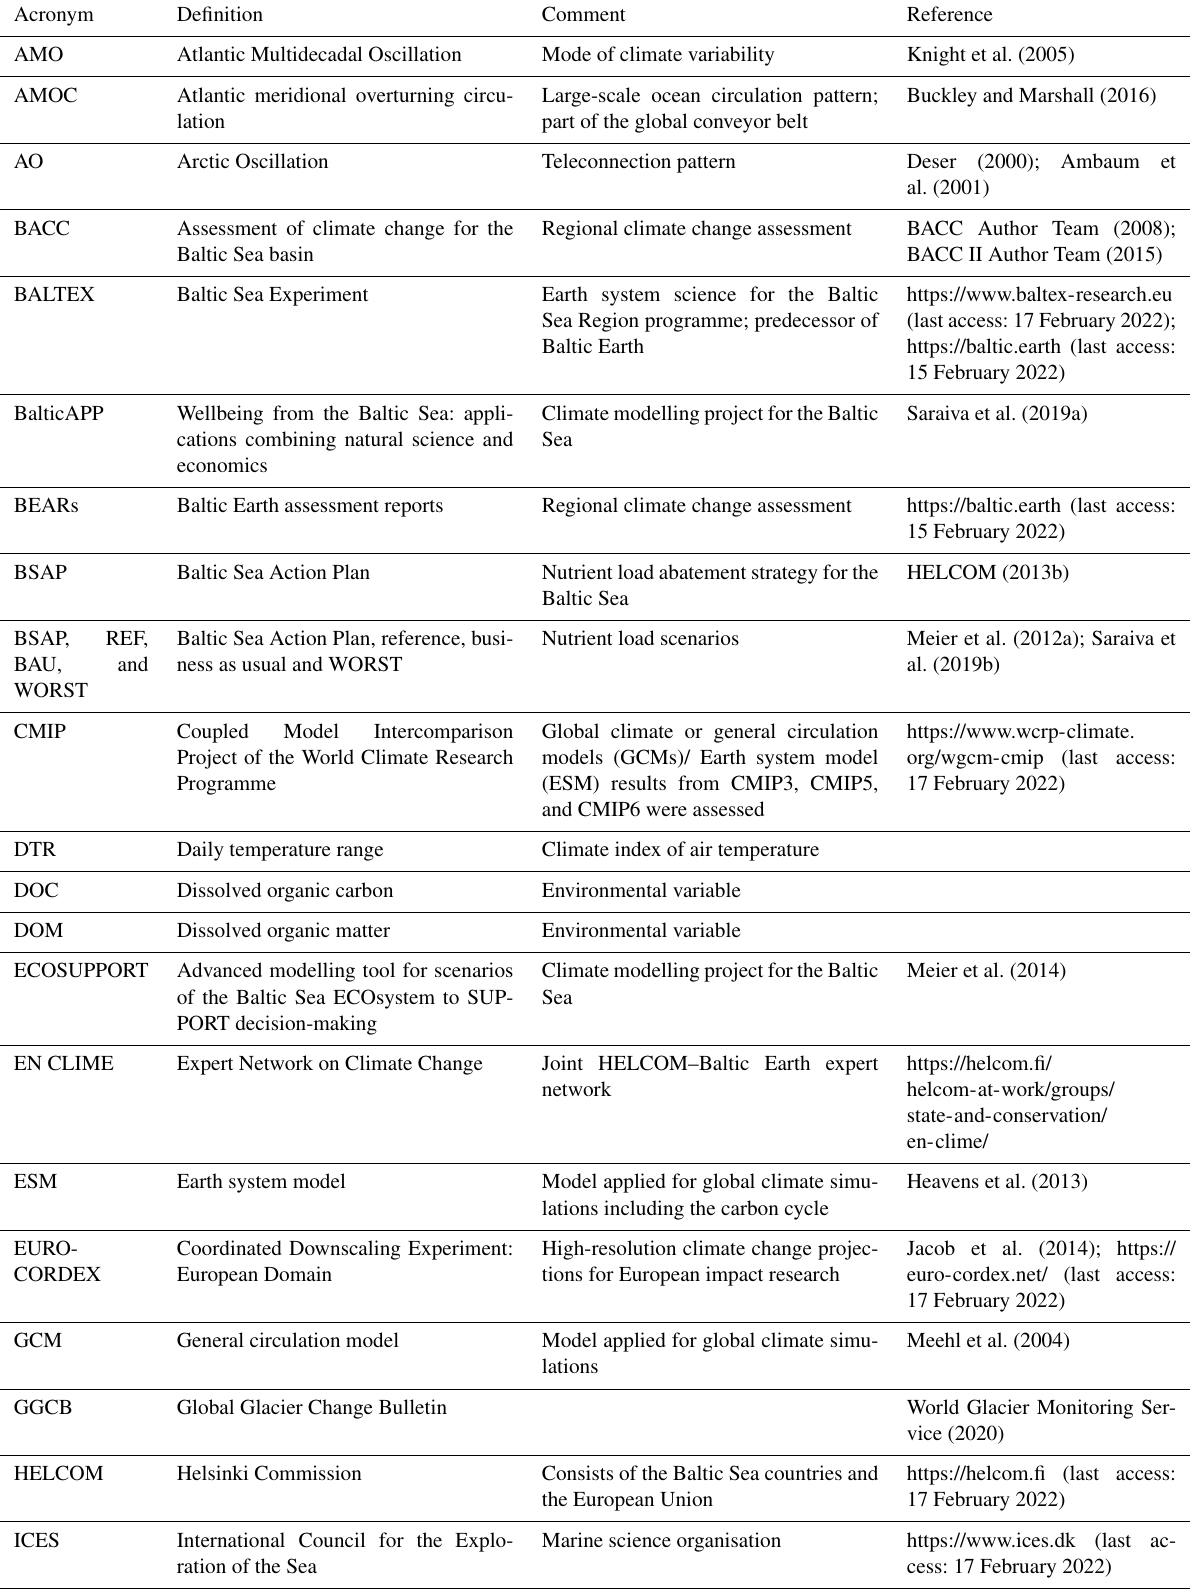
Table 3. List of acronyms (in alphabetical order), their definitions, comments, and references.